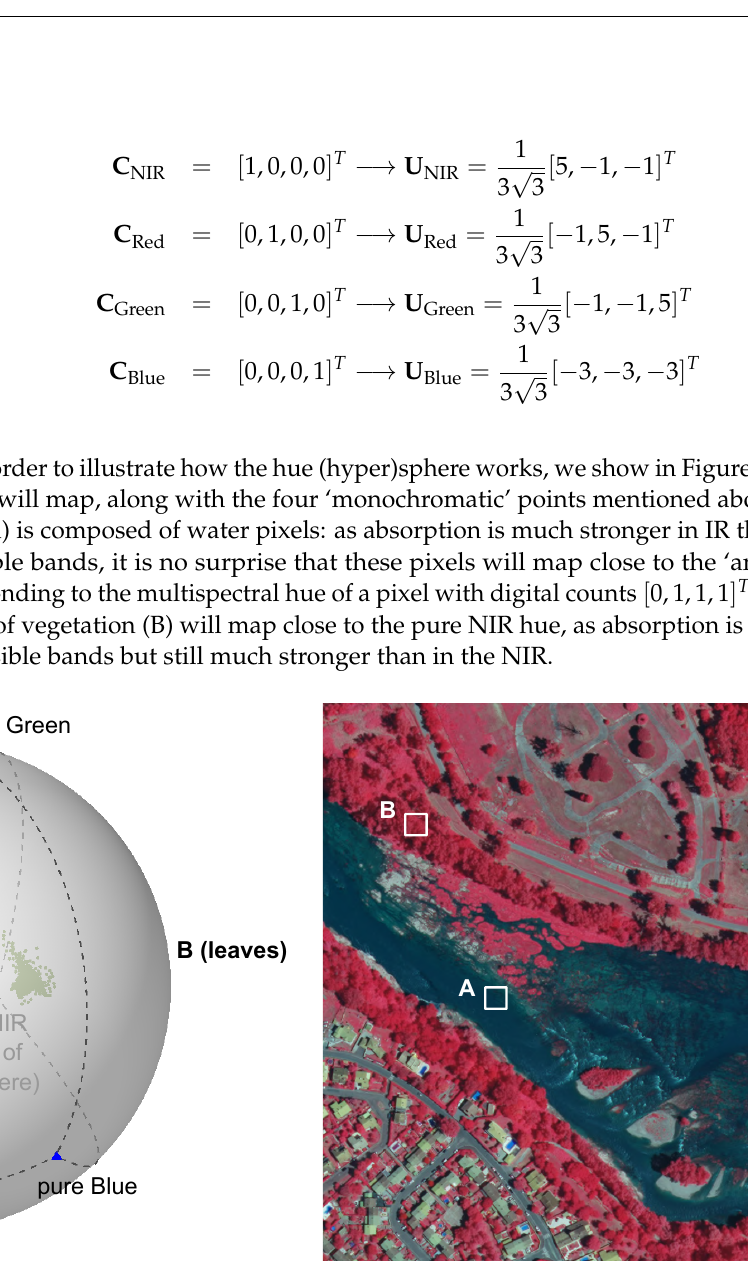
Figure 9. Representation of multispectral hue on the sphere S 2 for two terrain patches: a patch of water pixels (A) and a patch of vegetation pixels (B). Due to the low absorption in the visible bands and high absorption in the IR for water, and the opposite behavior for chlorophyll, the two patches map at the antipode of each other (close to the anti-NIR hue for water, and close to pure NIR hue for vegetation). The image displayed on the right is a NIR-R-G